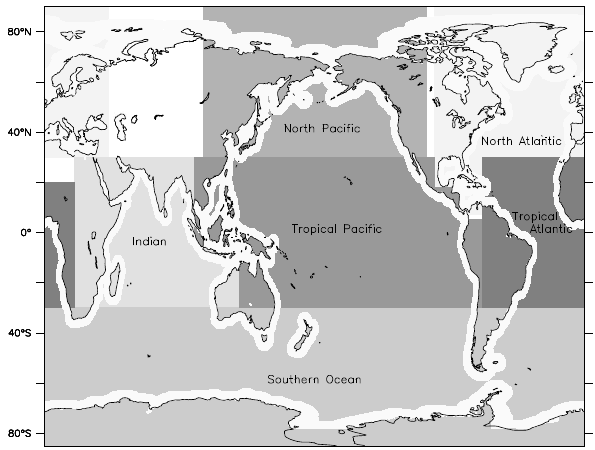
Figure 3. Oceanic and coastal regions in SOCAT (Table 1). The white collar surrounding land masses indicates the coastal regions. Coastal regions north of 30 ◦ S were quality controlled by the coastal group, while coastal regions south of 30 ◦ S were quality controlled by the Southern Ocean group.